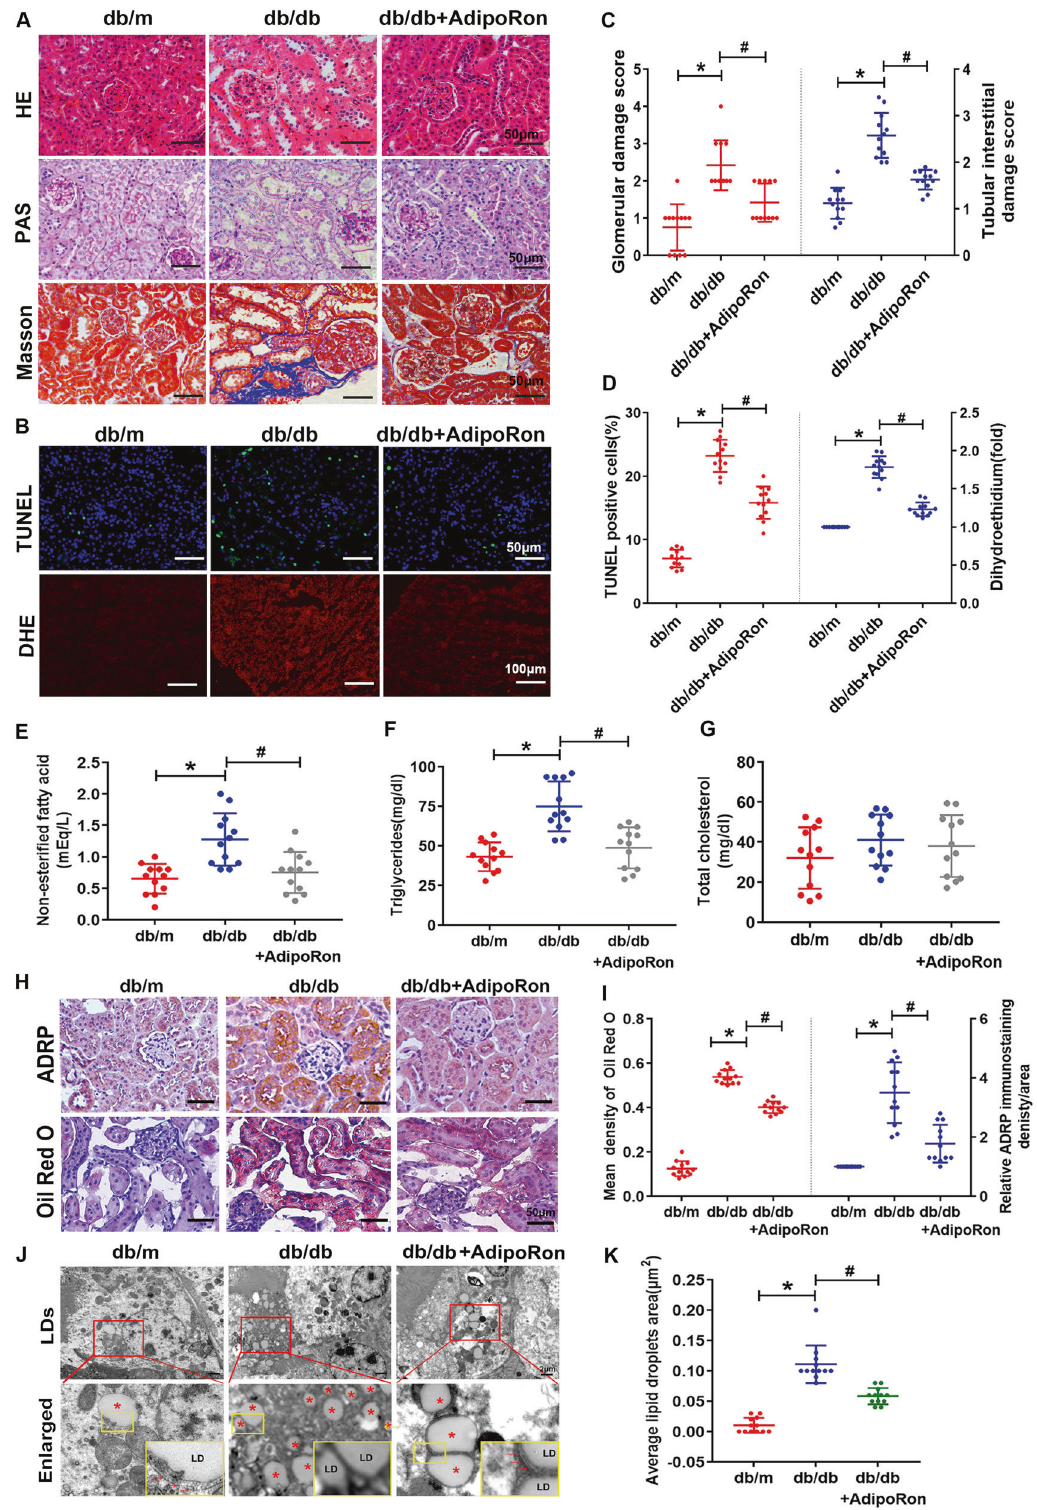
Fig. 3 AdipoRon increases lipophagy, ameliorated lipid deposition and renal pathological injury of db/db mice. Kidney sections stained with HE, PAS, Masson trichrome, TUNEL (magni fi cation, ×400) and DHE (magni fi cation, ×200) ( A , B ). Glomerular damage score and tubular interstitial damage score ( C ). TUNEL-positive cells in the kidney tissues and quantitative analysis of intrarenal DHE ( D ). Renal non-esteri fi ed fatty acids in the kidney tissues ( E ). Renal triglycerides ( F ). Renal total cholesterol ( G ). IHC analysis of ADRP and Oil-Red O staining in the kidneys ( H ). Semiquanti fi cation of the mean density of Oil-Red O and ADRP expression in the kidney ( I ). TEM analysis of lipid deposition in the kidney tissues of three groups of mice (magni fi cation, ×10,000). * indicates the LDs, and red arrows indicate double-membrane autophagic vacuoles containing lipidsnamely, lipophagy ( J ). Average LD area in the kidney tissues of the three mouse groups ( K ). Values are the mean ± SD; * p < 0.05 versus control group; # p < 0.05 versus db/db group. n = 12. Cell Death and Disease (2021)